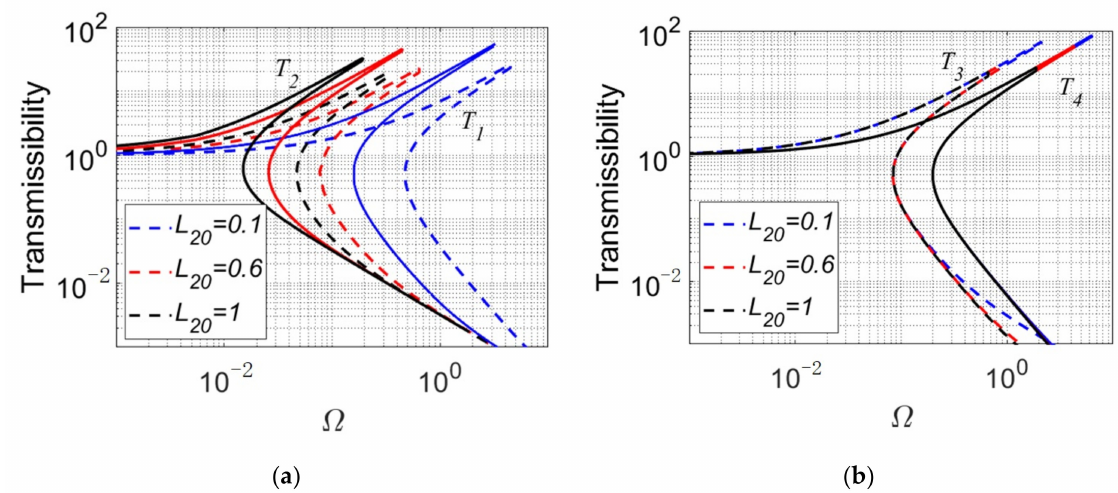
Figure 20. Comparison of displacement transmissibility in variation with slant length: ( a ) displace- ment; ( b ) rotation. Dash lines show the vertical results, solid lines show the horizontal results.